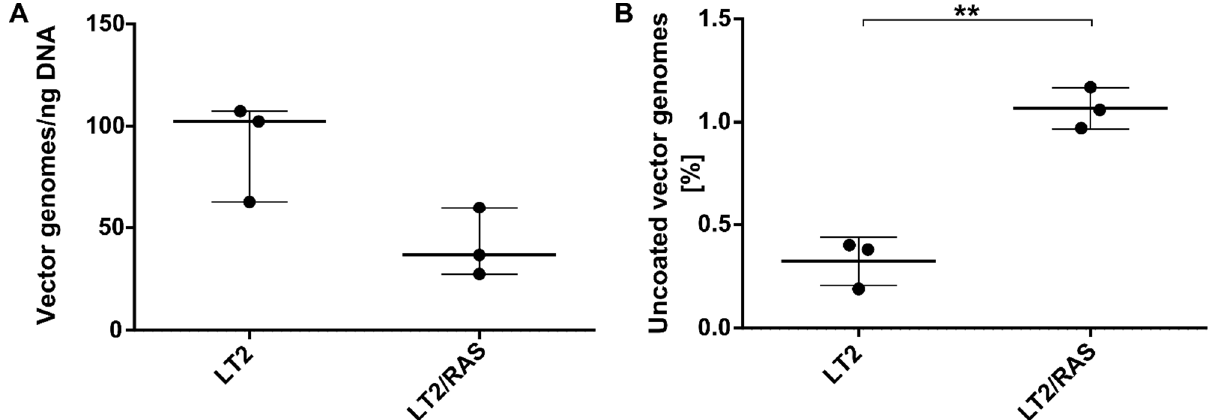
Figure 7. Quantification of T5-resistant episomal vector DNA as indication for uncoating efficiency in HCC and liver samples of AAV2 vector-treated LT2 and LT2/RAS mice. The number of AAV vector genomes in episomal form was compared between healthy liver tissue (LT2) and tumor-bearing liver tissue (LT2/RAS) seven days after vector administration. Samples were obtained from the animals shown in Figure 6. ( A ) Total and ( B ) uncoated vector genomes (episomal conformation) were quantified by qPCR in tissue DNA after mock treatment or T5 exonuclease treatment, respectively. Data are shown in linear scale and as ( A ) Firefly luciferase transgene copies normalized to ng DNA per reaction and ( B ) mean percentage of uncoated vector genomes in mock-treated tissue DNA. Statistics: ( A ) Unpaired two-tailed t -test with Welch’s correction (ns); ( B ) Unpaired two-tailed t -test (** p < 0.01). N = 3